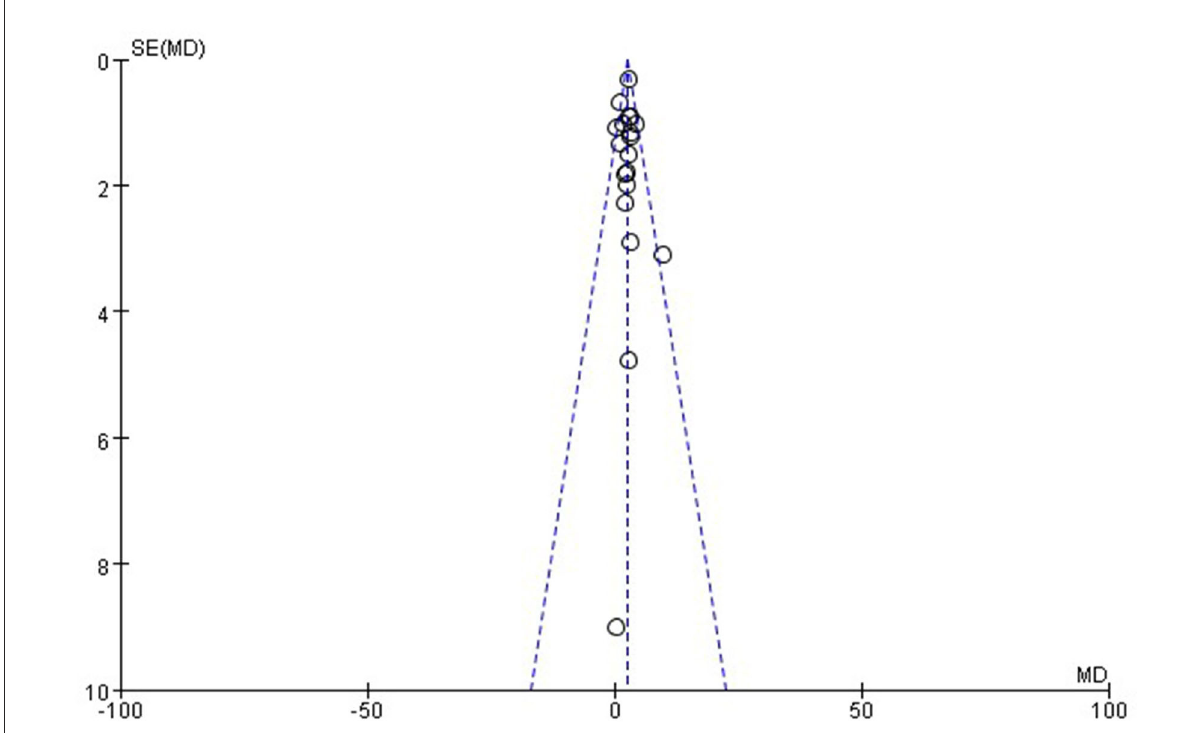
FIGURE12 Funnel chart of publication